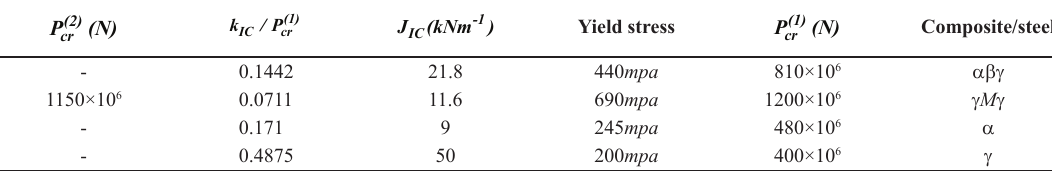
Table 2. Mechanical propertes and critical normal loads for